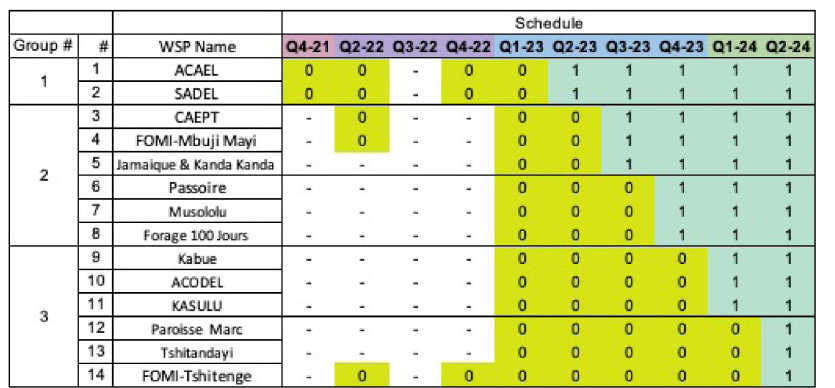
Fig 2. Data collection schedule. Data collection schedule for the 14 WSPs included in the University of Colorado Boulder study design from 2022–2025 surveying rounds.